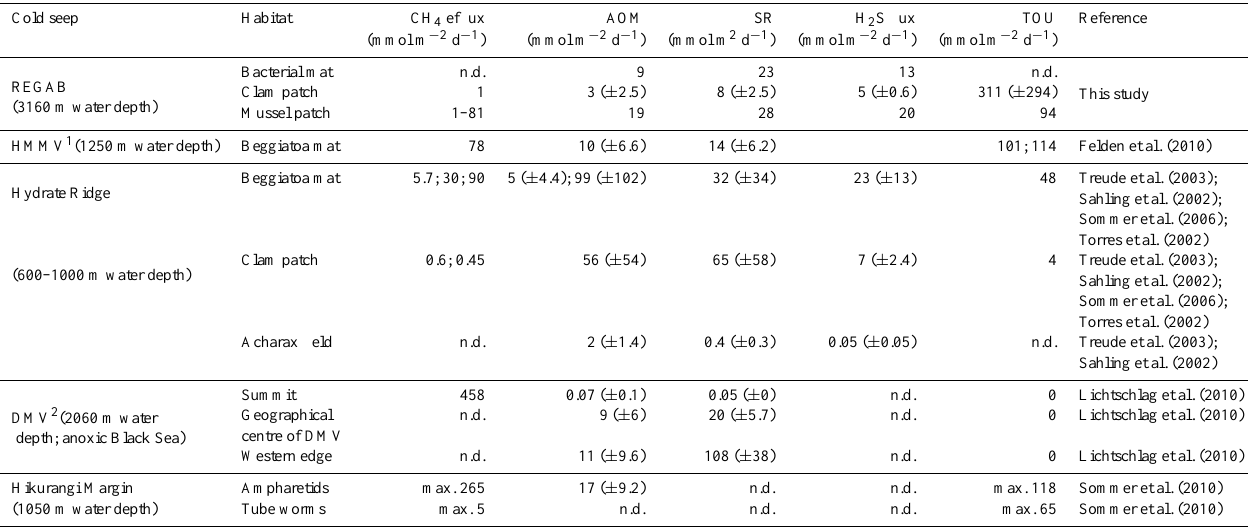
Table 6. Compilation of in situ CH 4 effluxes and total oxygen uptake (TOU), ex situ average integrated anaerobic oxidation of methane (AOM) and sulphate reduction (SR) rates, as well as H 2 S fluxes from cold seep sites worldwide, including data from REGAB (this